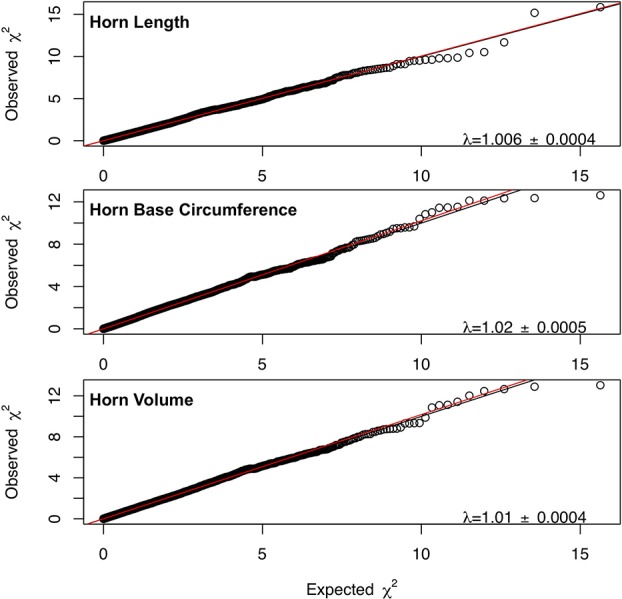
Q-Q plots for each horn size trait with the genome inflation factor and standard error printed on the bottom right corner of each plot. The black line represents a 1:1 correspondence, while the red line is a regression through the observed data.